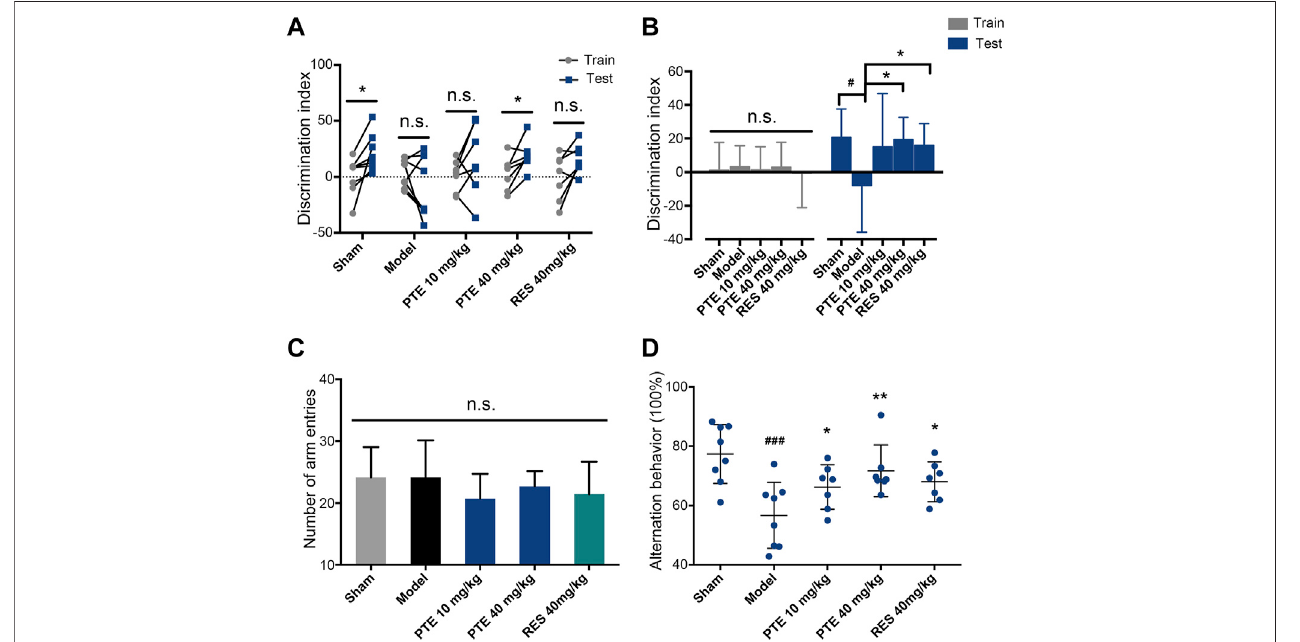
FIGURE 3 | Effects of PTE and RES on the novel object test and Y-maze test in AD mice. (A – B) Discrimination index of each mouse (A) and the average discriminationindex ofeach group (B) duringtrainingand testing periods inthenovel objecttest. (C – D) Thetotalnumberofarmentries (C) andspontaneousalternation behavior (D) in the Y-maze test. Data are shown as mean ± SD (n = 7 – 8). # p < 0.05, ### p < 0.001 vs sham; * p < 0.05, ** p < 0.01 vs model.